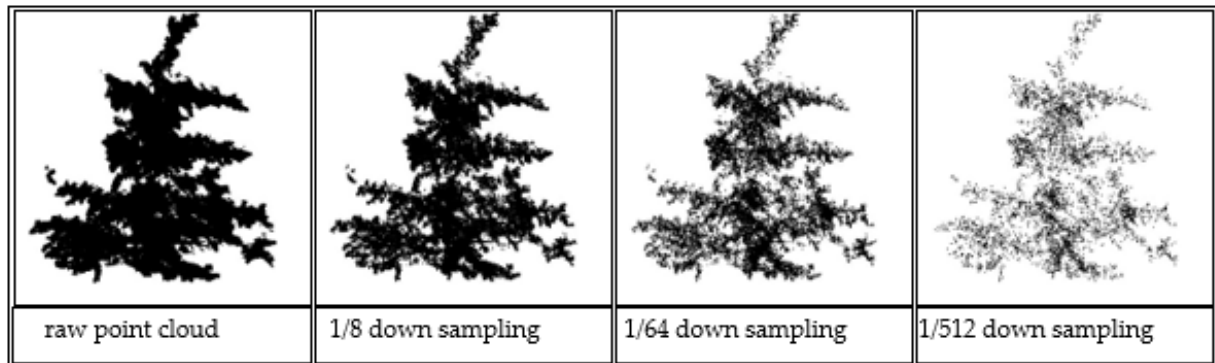
Figure 7. Trend of the fractal dimension with point cloud down sampling of ginkgo trees 1 to 3.